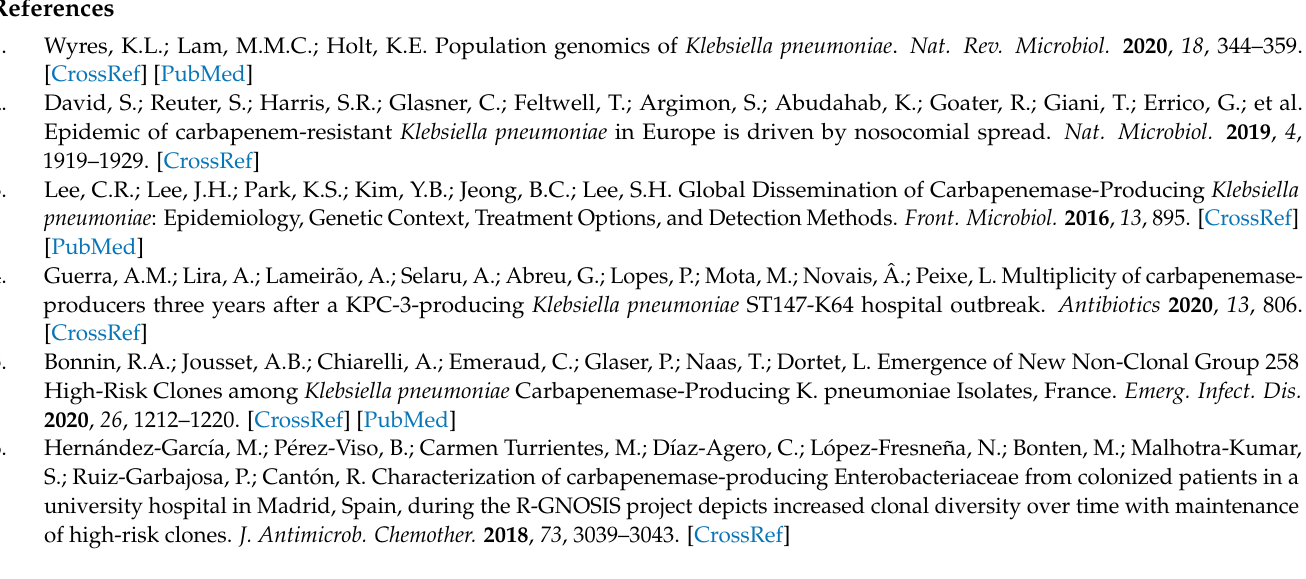
moniae ST11 KL105 genomes, supporting phylogenetic